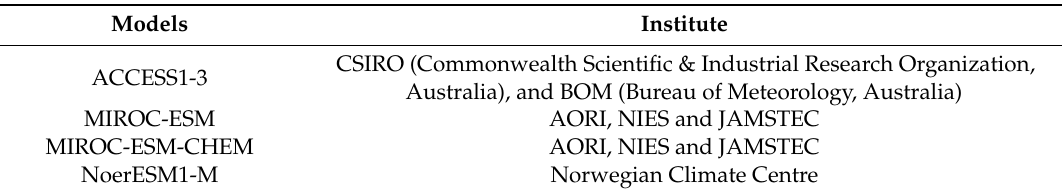
Table 1. Coupled model inter-comparison project phase 5 (CMIP5) general circulation models used in the study at 0.5 ◦ × 0.5 ◦